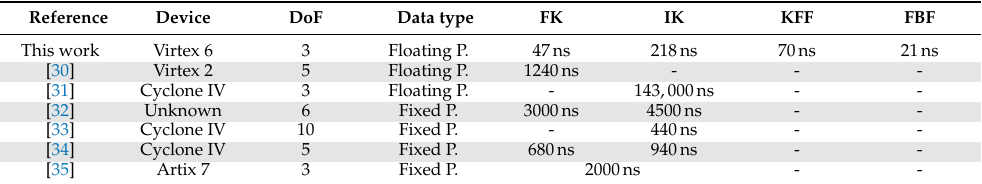
Table 4. Comparative table with state of the art